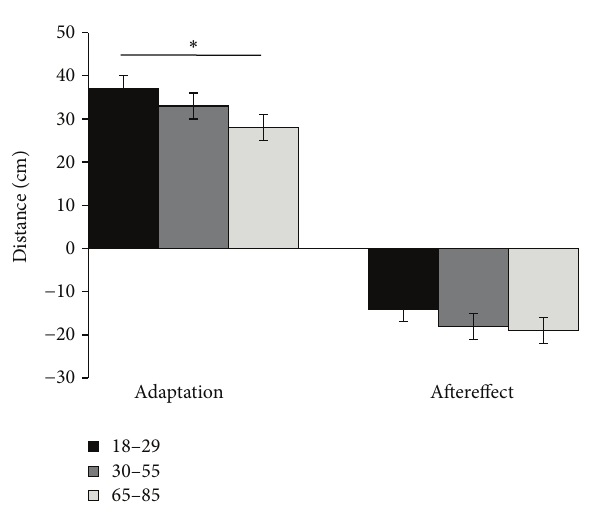
Figure 1: Left: adaptation magnitude in young (black), middle- aged (gray), and older aged (light gray) groups during displacement experiment. Right: aftereffect magnitude in young, middle-age, and elderly group. Bars represent standard errors; asterisk (∗) denotes 𝑝 = 0.012 .